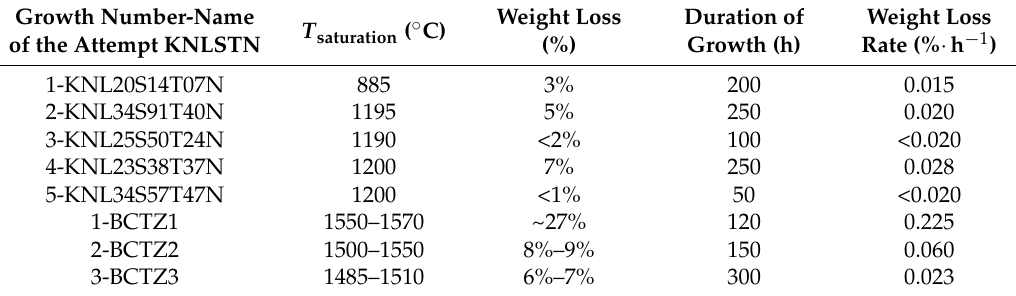
Table 4. Saturation temperatures, weight losses percentage, crystal growth durations, and weight loss rate due to volatilization with respect to the growth attempts for KNLSTN and